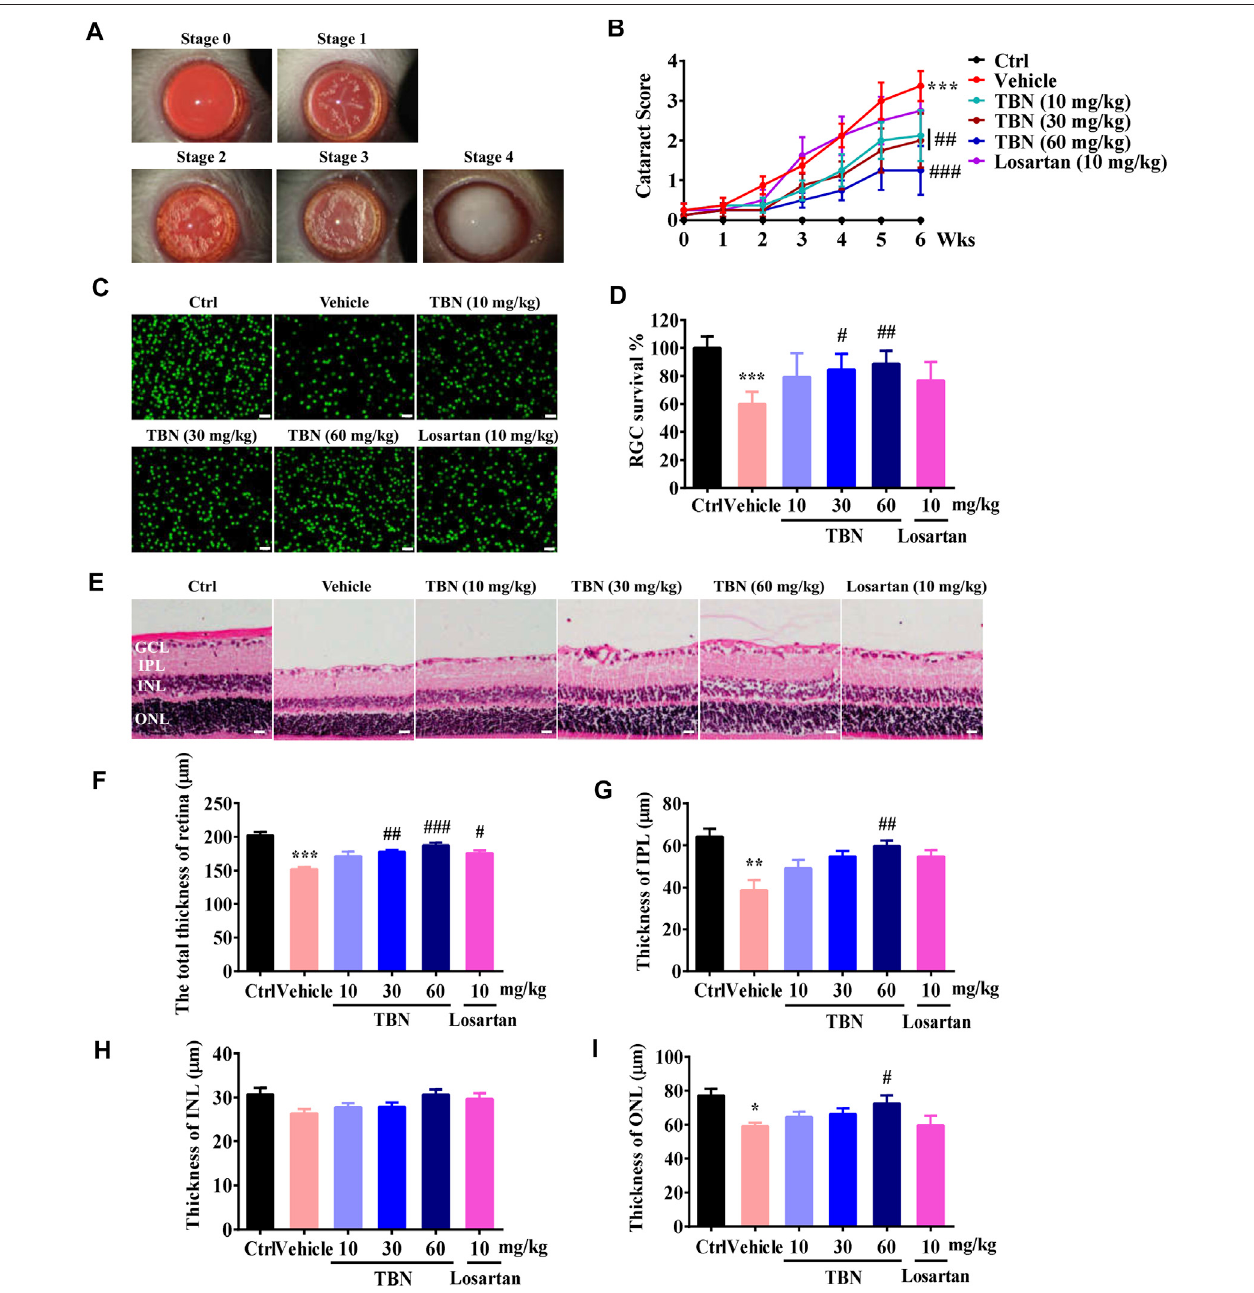
FIGURE 5 | TBN alleviates cataract severity and retinal thickness reduction in STZ-induced rats. ( A) Representative images of cataracts for stage scoring. ( B) Cataracts were scored every week beginning at 3 weeks post-STZ injection. Data were means ± SEM of eight rats per group. ( C) Representative immuno fl uorescence imagesofBrn3a stainingintheretinas.Scalebars,50 µm.( D) RGCsurvivalrateinthedifferentgroups.( E) H&Estainingoftheretina. ( F-I) Thickness ofeach retinal layer wasmeasured. GCL, ganglioncell layer. IPL, internal plexiform layer. INL, internalnuclear layer. ONL, outer nuclear layer. Scalebar: 20 μ m. All datawere shown as themean ± SEMof5 – 6ratspergroup. Datawereexpressed asmean ± SEM.Signi fi cance wasdeterminedbytwo-way ANOVA in fi gure Borone-wayANOVAfollowed by tukey ’ s multiple comparisons test. * p < 0.05, ** p < 0.01 and *** p < 0.001 vs. Ctrl group. # p < 0.05, ## p < 0.01, and ### p < 0.001 vs. vehicle-treated group.